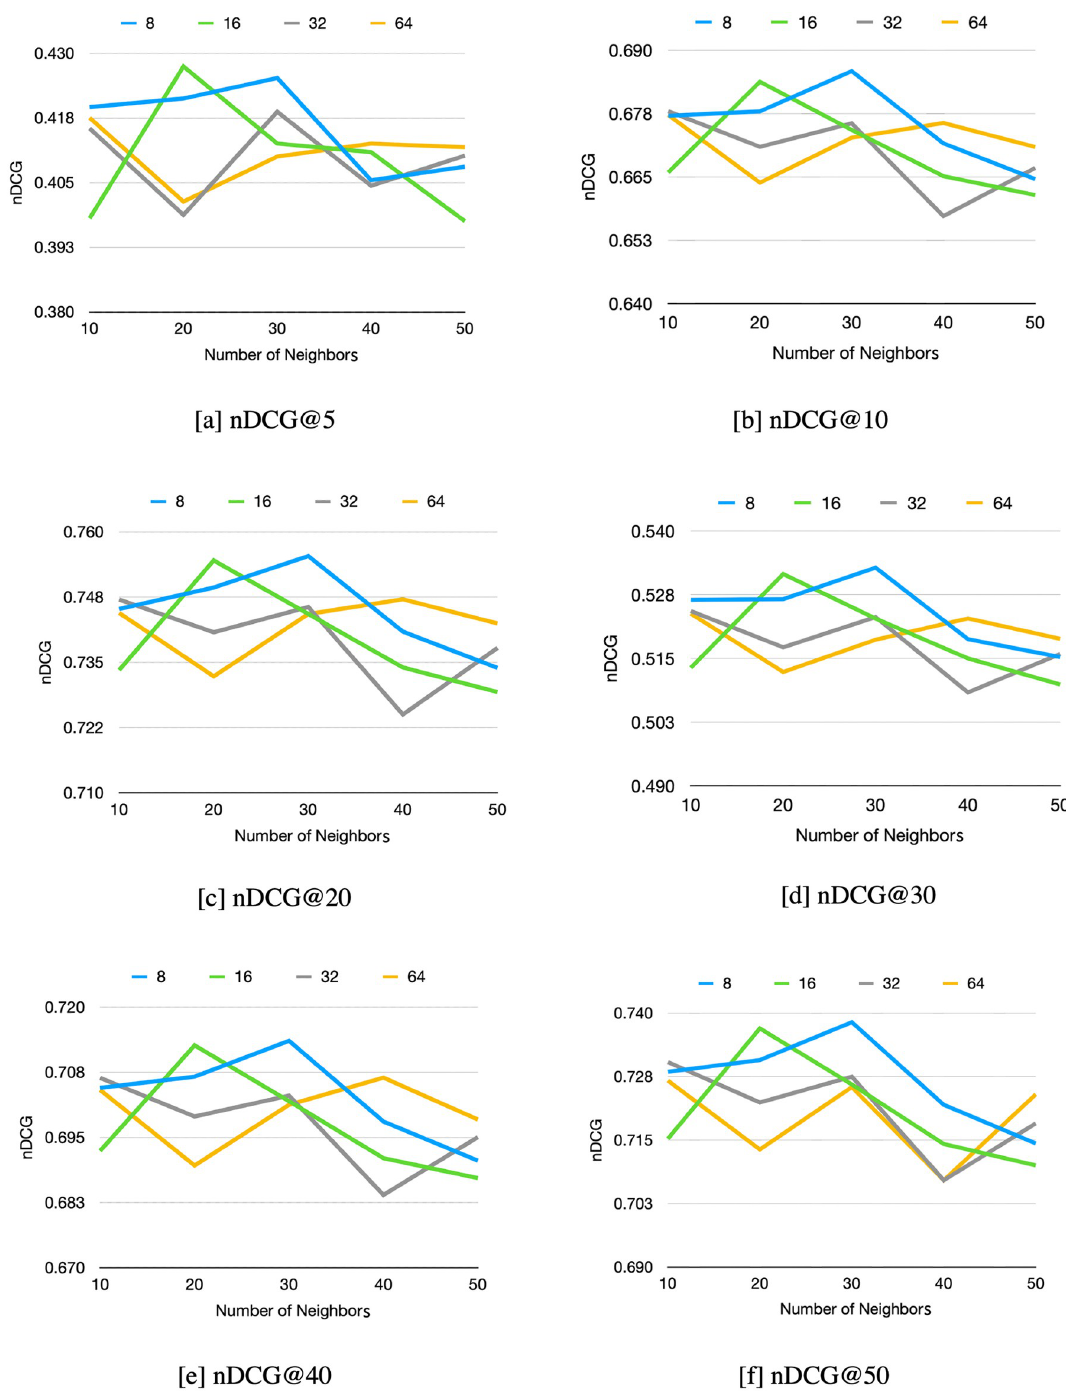
Fig 6. Experimental results of the Movielens 1M dataset for the proposed method varying the embedding size and neighbors. [a] nDCG@5. [b] nDCG@10. [c] nDCG@20. [d] nDCG@30. [e] nDCG@40. [f] nDCG@50.